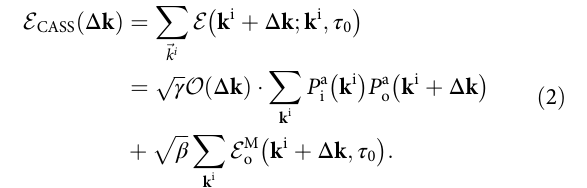
Fig. 1b. By taking the Fourier transform of these images, we could (cid:1) obtain the angular spectrum of backscattered waves E k o ; k i ; τ 0 (cid:1) (cid:3) in the form of matrix for each k i . Figure 2c shows E k o ; k i ; τ 0 with its column and row indices set by k i and k o , respectively.